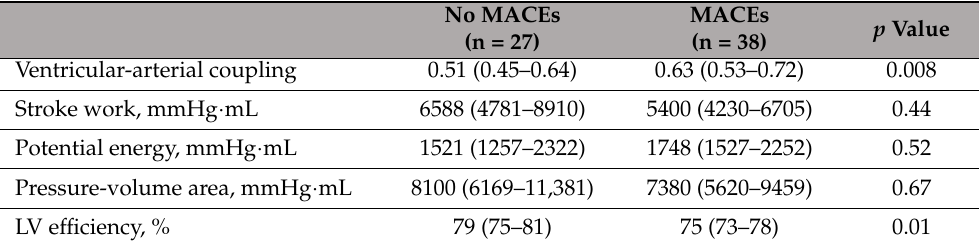
Abbreviations as in Table 1. Values are mean ± SD or median (IQR).